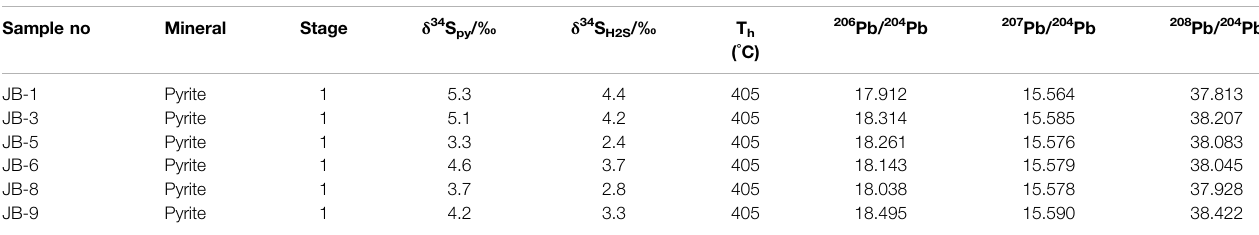
TABLE 4 | Sulfur and lead isotope data for pyrite from the Jinba gold deposit. Sample no Mineral